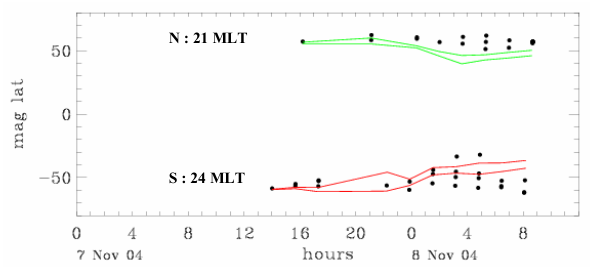
Fig. 3. Temporal variation of the latitudes which correspond to the boundaries of duskward flows, as deduced from the ADV measure- ments at 21:00 and 24:00 MLT sectors of the Northern (green line) and Southern (red line) Hemispheres, respectively. Dots indicate the latitudes of the observed O + outflow with the mean velocity higher than 200ms − 1 . The observations were made at the latitudes below magnetic 62 ◦